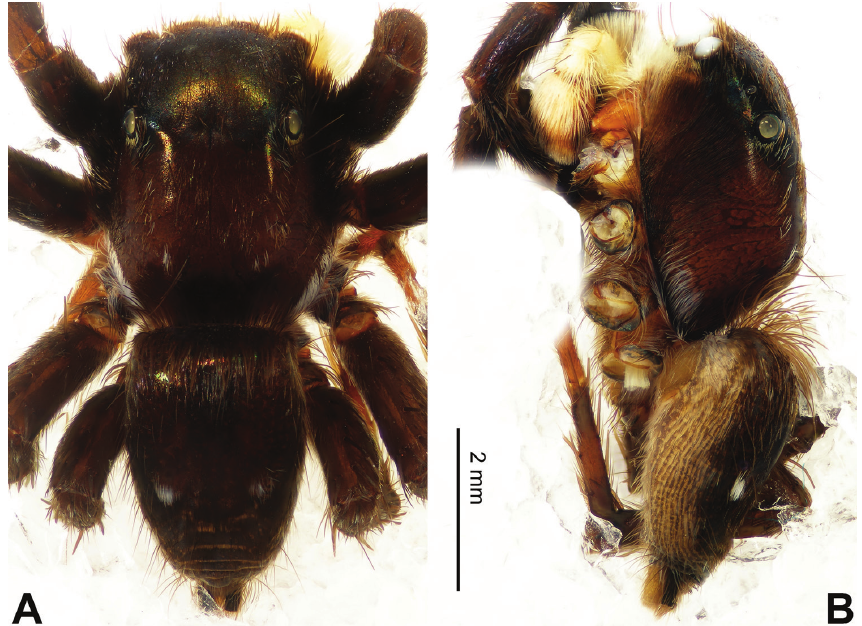
Figure 42. Habitus of Stenaelurillus fuscus sp. n., male holotype. A dorsal B